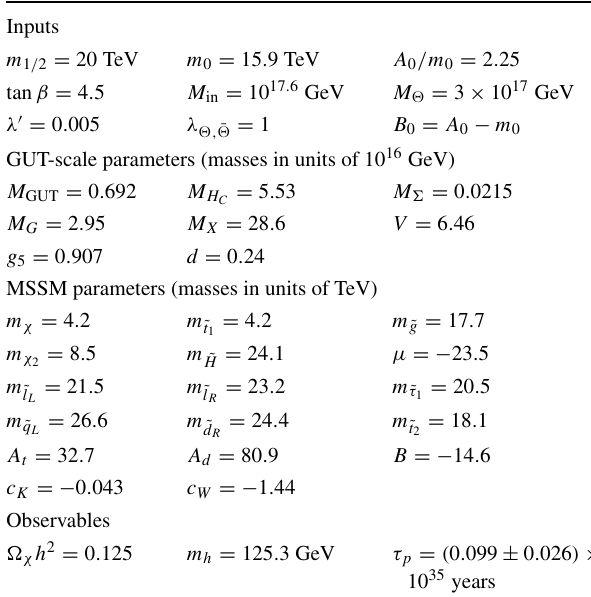
Table 1 Benchmark point parameters. We first give the input parame- ters defined at M in , with the exception of the Yukawa couplings, which are defined at M GUT , and assume μ < 0. The second set of parame- ters are GUT scale quantities determined by the matching conditions described in the text. The third set of quantities are derived from the running of the RGEs and matching at the weak scale. We find that − m χ = 12 GeV at this point. The chargino masses are nearly m ˜ t 1 degenerate with the wino and Higgsino masses given as m χ and m ˜ , H 2 m ˜ τ is similar to m ˜ , m ˜ u is similar to m ˜ q , m ˜ is similar to m ˜ t , and l L b 1 R L 2 2 m ˜ is similar to m ˜ . Other A -terms take values between A t and A d . b 2 d R The final entries correspond to the observables we concentrate on